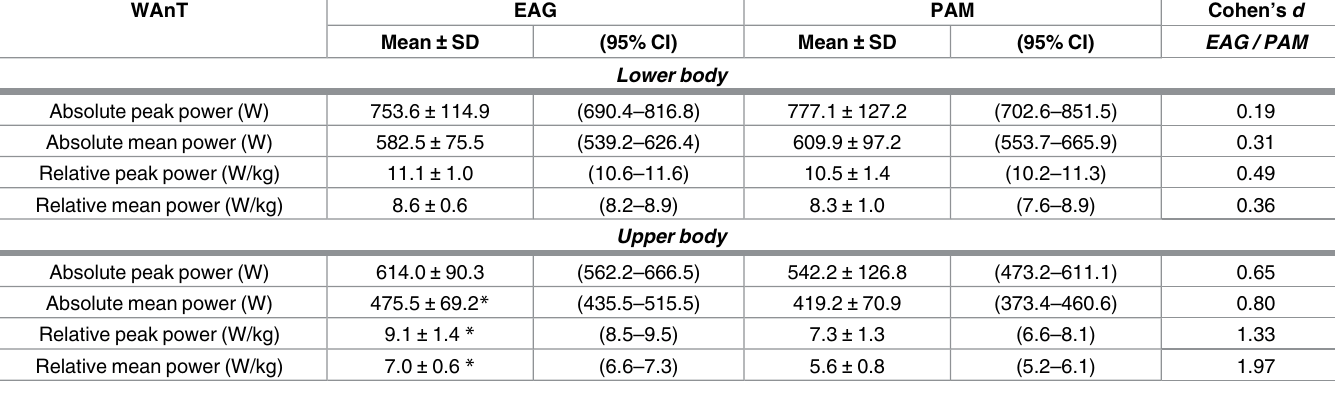
Table 3. Lower and upper body Wingate Anaerobic Test (WAnT) characteristics of elite artistic gymnasts (EAG) and physically active men (PAM) in mean and standard deviation